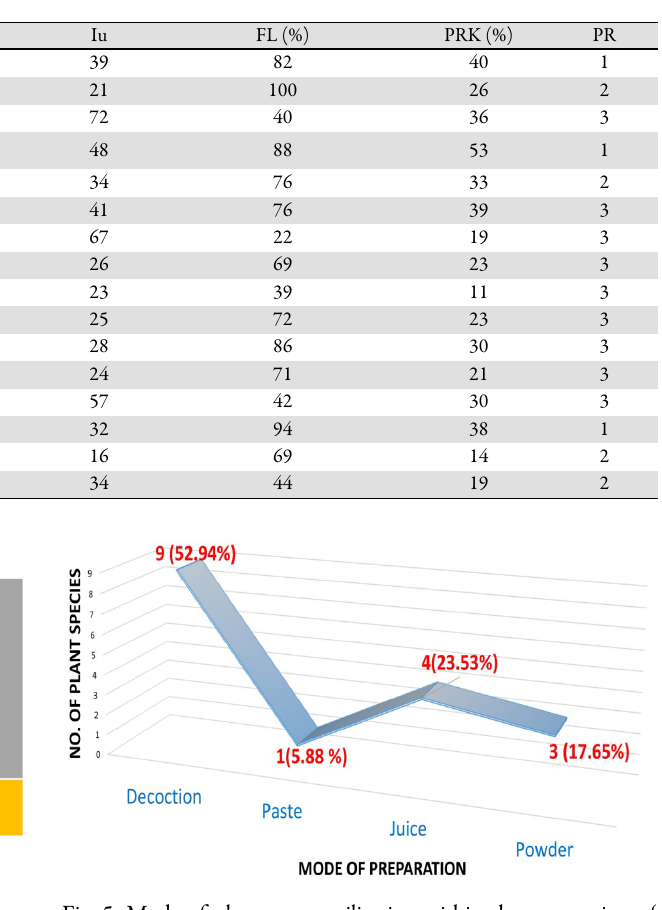
Fig. 5. Mode of plants parts utilization within the preparation